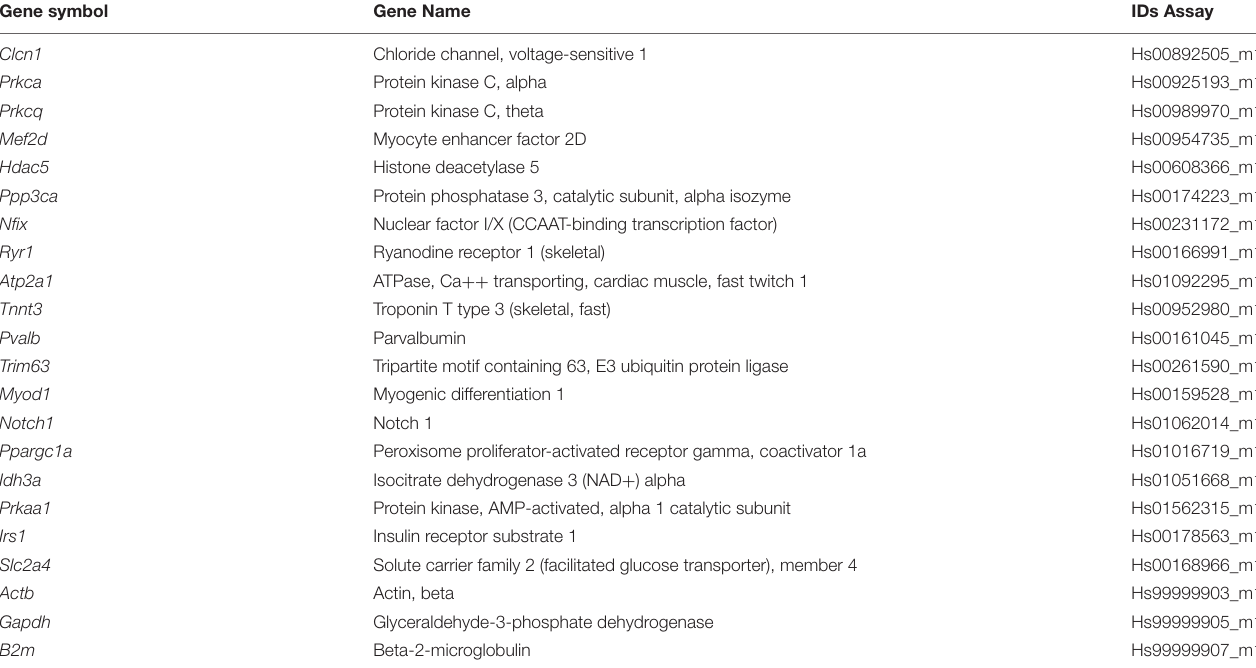
TABLE 2 | List of genes analyzed and quantified in human muscle biopsies by real-time PCR (Applied Biosystem). Gene